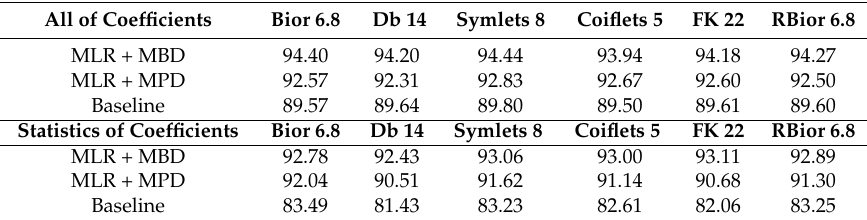
Table 18. Method performance in different feature spaces on MLV.